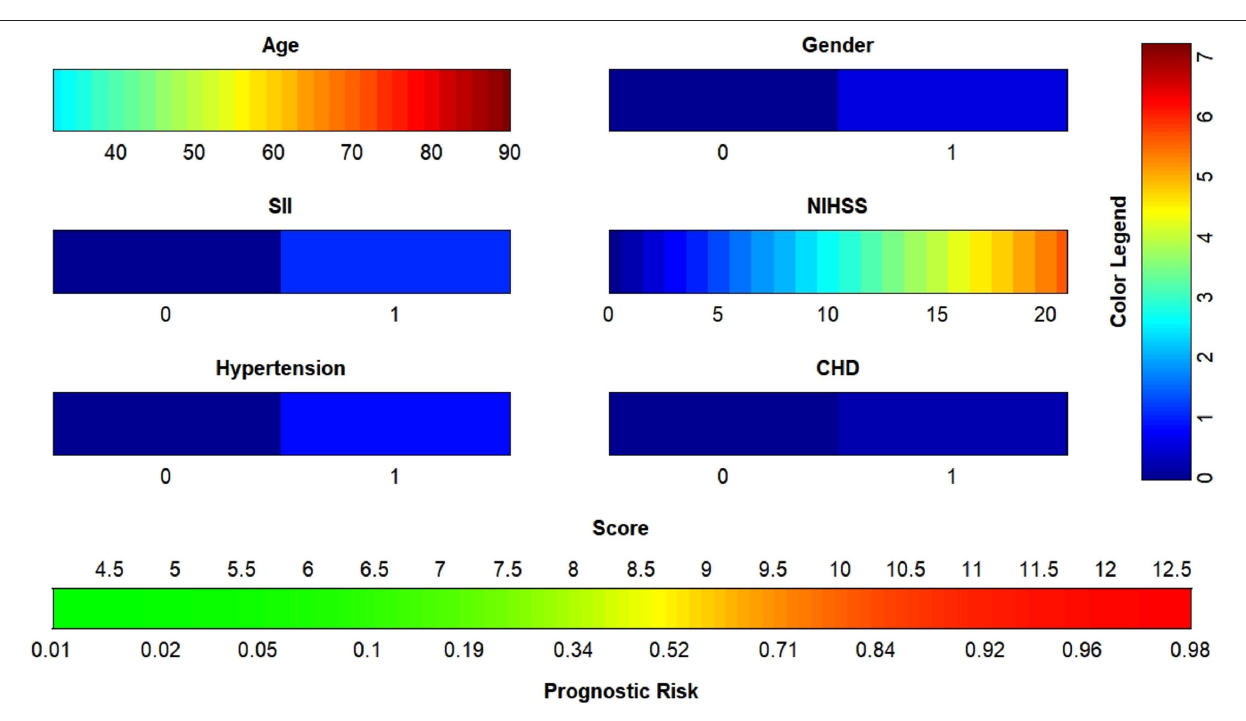
FIGURE 4 | Nomogram to predict the risk of adverse outcome for AIS patients in 3 months. SII, systemic immune inflammatory index; NIHSS, National Institutes of Health Stroke Scale; CHD, coronary heart disease; AIS, acute ischemic